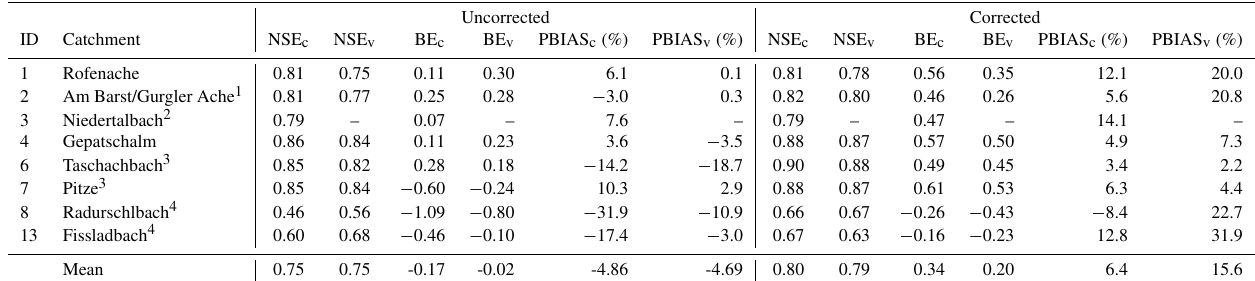
Table 7. NSE, BE, and PBIAS of simulated vs. observed runoff obtained using uncorrected and corrected precipitation. Calibration and validation periods are – if not otherwise stated – 1998–2006 and 2007–2013, respectively. The subscripts c and v denote calibration and validation periods,